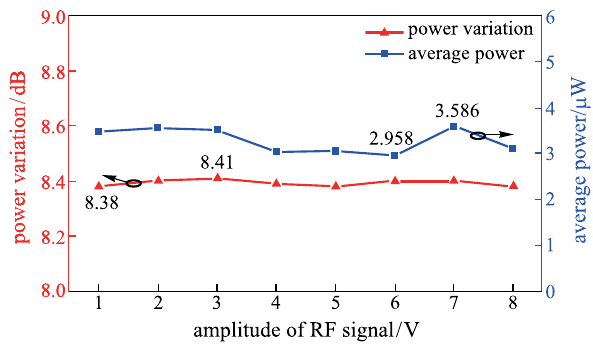
Fig. 6 Influence of the amplitude of the RF source signal on the flat- ness and average power of